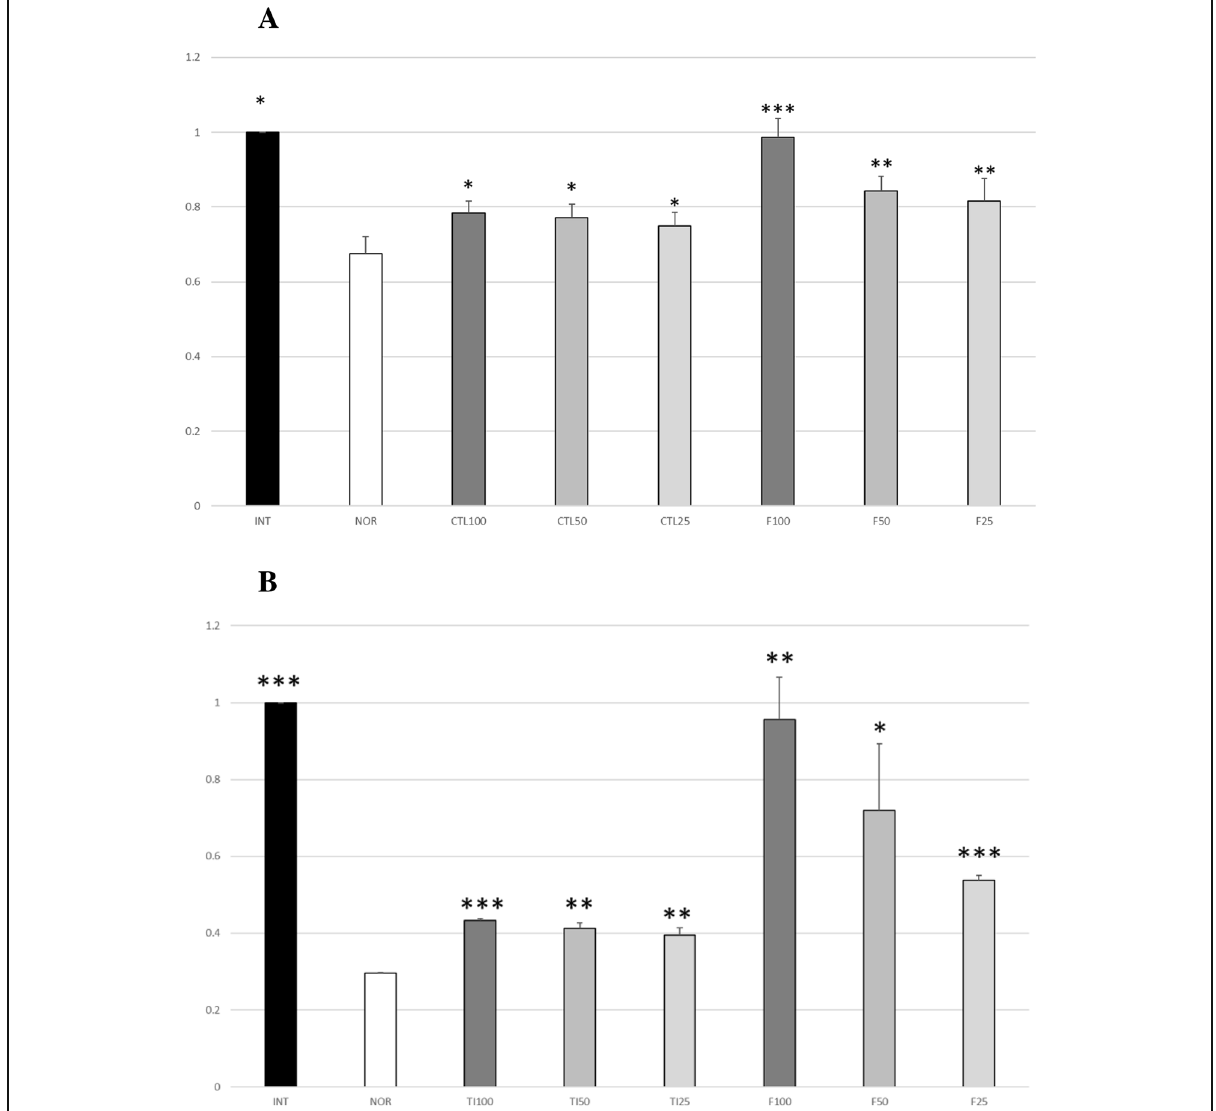
Fig. 2 Relative testosterone level upon treatment with ( a ): Carpinus tschonoskii leaf (CTL) extract and ( b ): tellimagrandin I (TI). The results are expressed as mean ± standard deviation (SD) of triplicate experiments. ( n = 3) ***, p < 0.001; **, p < 0.01; *, p < 0.05, comparison with